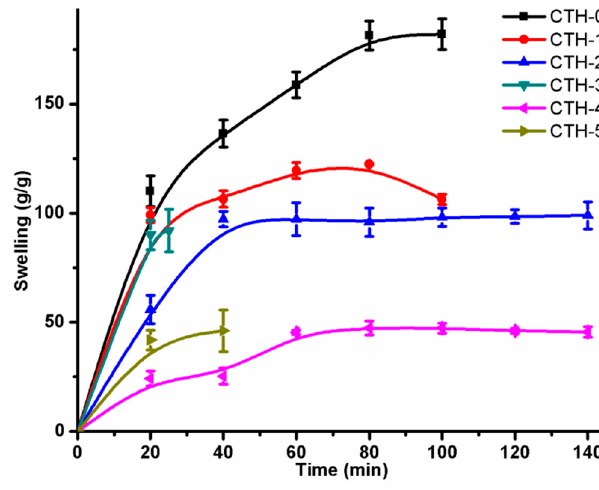
Figure 5. Swelling behaviour of CS / PAH films with di ff erent compositions in deionized water.